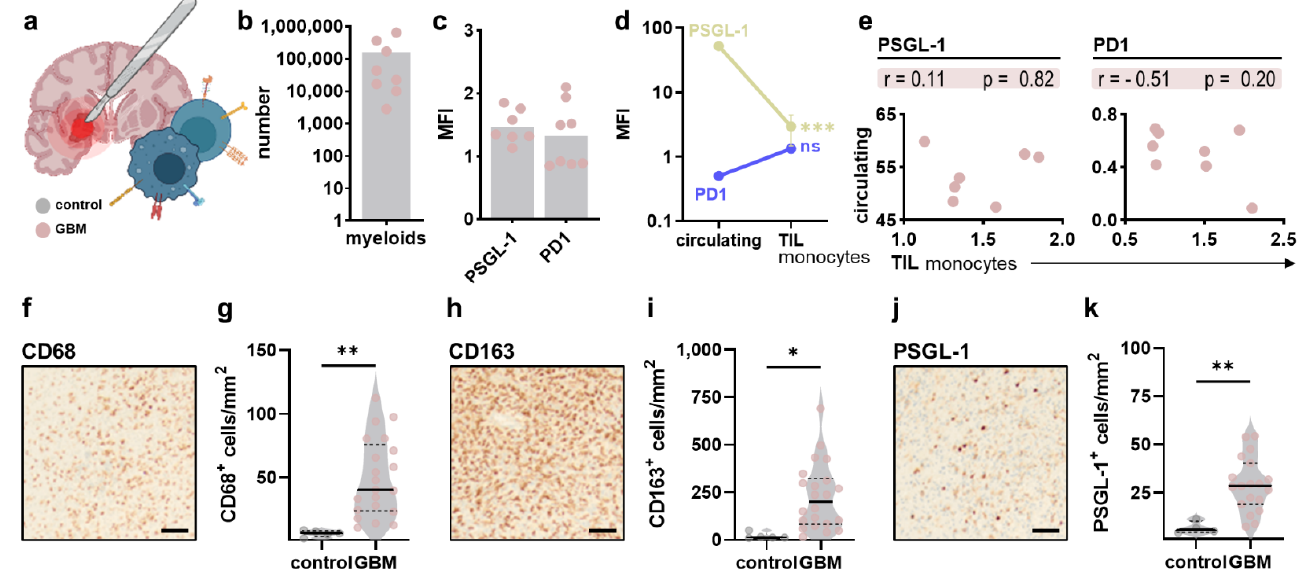
Figure 4. Myeloid immune infiltration in glioblastoma tumors. ( a ) schematic overview of intra- tumoral immune profiling after neurosurgical resection of tumor samples; ( b ) absolute numbers of myeloid cells in tumor samples; ( c ) surface expression of PSGL-1 and PD1 on intratumoral myeloid cells; ( d ) comparison of PSGL-1 and PD1 expression on circulating and tumor-infiltrating myeloid cells; ( e ) Pearson’s correlation of PSGL-1 and PD1 expression on circulating and tumor-infiltrating myeloid cells; ( f – k ) representative immunohistochemical images and quantification of CD68 + ( f , g ), CD163 + ( h , i ) and PSGL1 + cells ( j , k ) in control and malignant brain tissue. Bar graphs show mean + individual values. Statistical analysis was performed using paired t -test (* p < 0.05, ** p < 0.01).